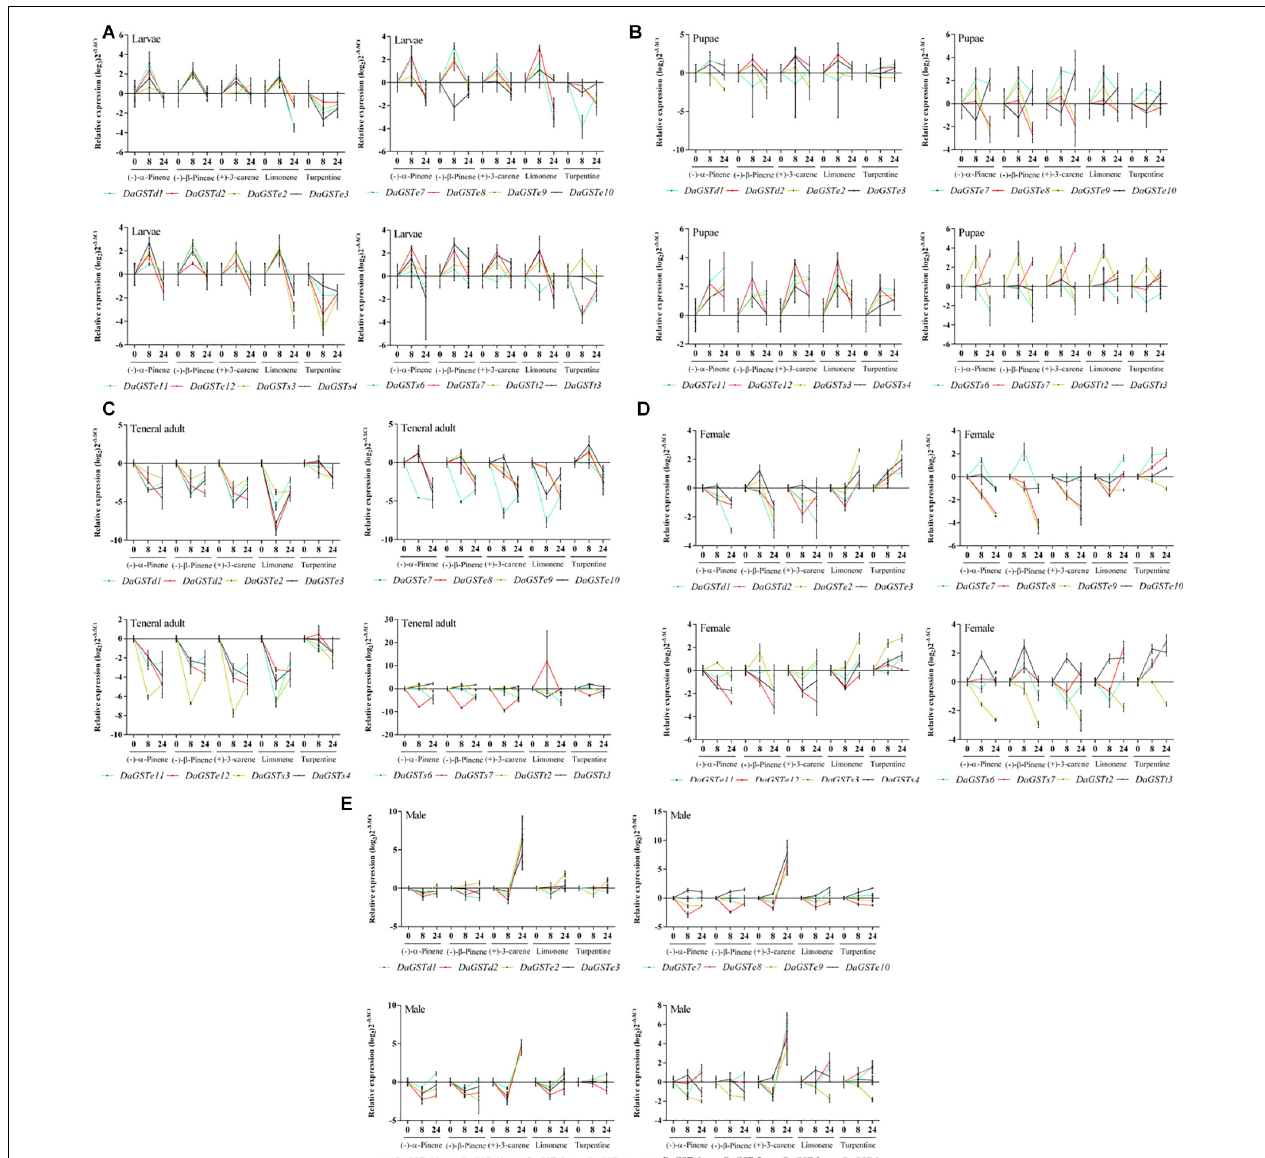
FIGURE 5 | Quantitative expression of GST genes (mean ± SE, n = 3) in different life stages ( A: larvae; B: pupae; C: teneral adult; D: emerged female adults; E: emerged male adults) of Dendroctonus armandi after stimulation with five terpenoids at exposure times of 0, 8, and 24 h. GST expression was normalized to the transcription level geometric mean of β - actin and CYP4G55 . The 2 - (cid:49)(cid:49) Ct and SE values were log 2 transformed for plotting. Statistically significant differences in gene expression are shown in Supplementary Tables S4, S5